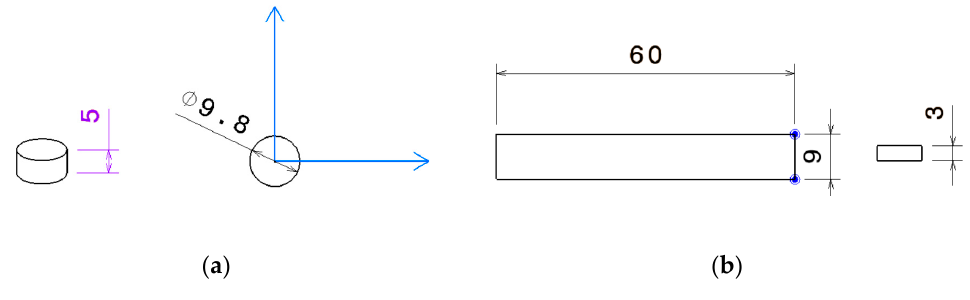
Figure 6. Sample geometry: ( a ) TMA; ( b ) DMA.